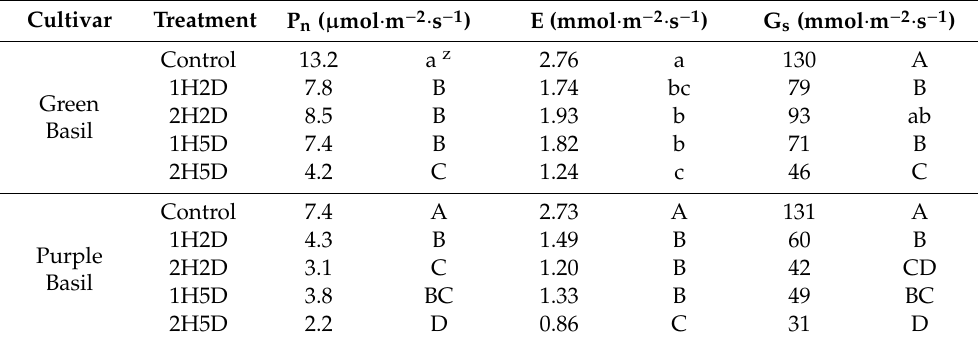
Table 1. Net photosynthetic rate (P n ), transpiration rate (E), and stomatal conductance (G s ) of green basil ‘Improved Genovese Compact’ and purple basil ‘Red Rubin’ plants under five supplemental UV-B radiation treatments, including no supplemental UV-B radiation (control), 1 h · d − 1 for 2 days